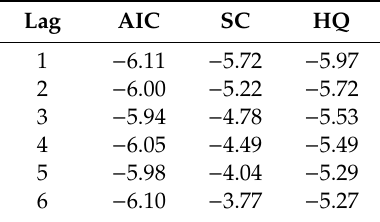
Table 2. P-step lag values of AIC 1 , SC 2 and HQ 3